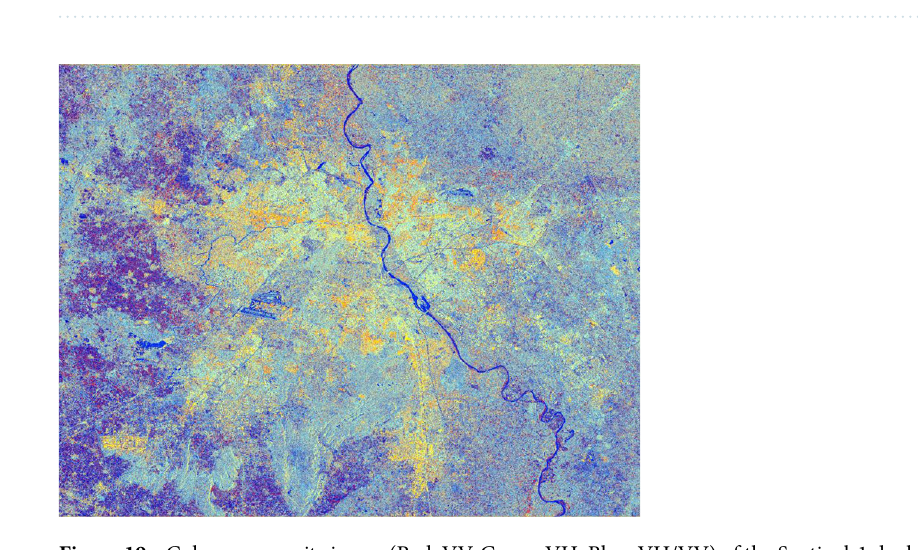
Figure 18. Colour composite image (Red: VV, Green: VH, Blue: VH/VV) of the Sentinel-1 dual-polarization C-band data in with a window size of 13 and sigma value of 0.5.